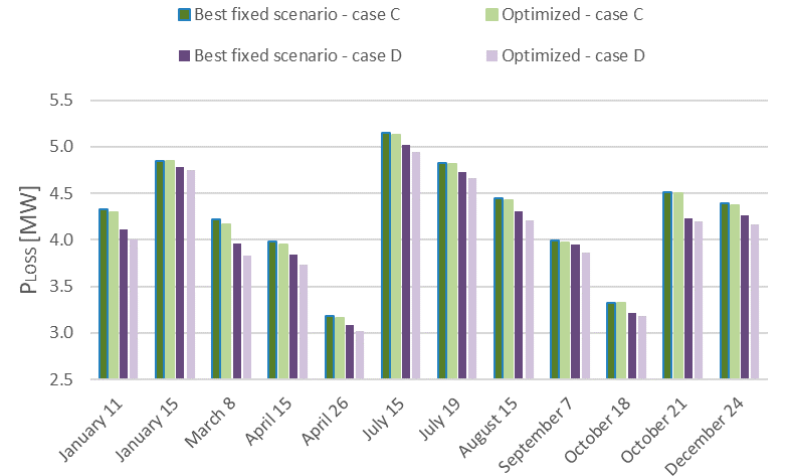
Figure 8. The comparison between daily losses in the Croatian network, case C and case D.